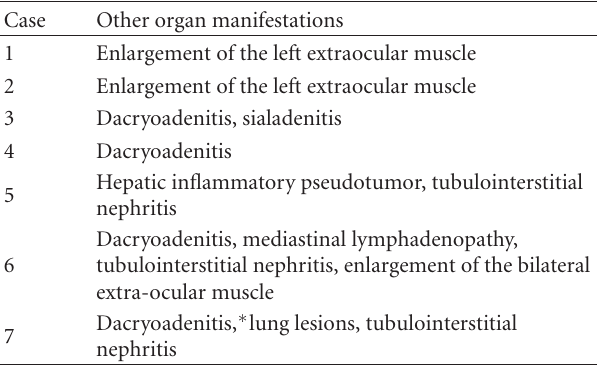
Table 2: IgG4-related disease identified in other